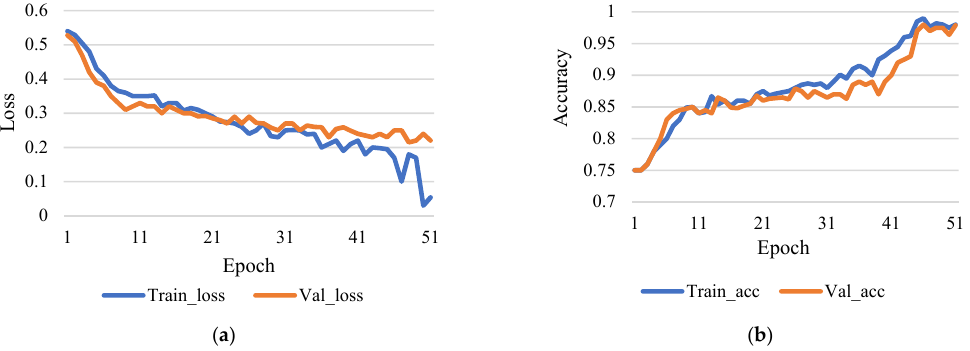
Figure 4. ( a ) Training loss vs validation loss (rate of learning 0.0001 and epoch 50). ( b ) Training accuracy vs validation accuracy (rate of learning 0.0001 and epoch 50).